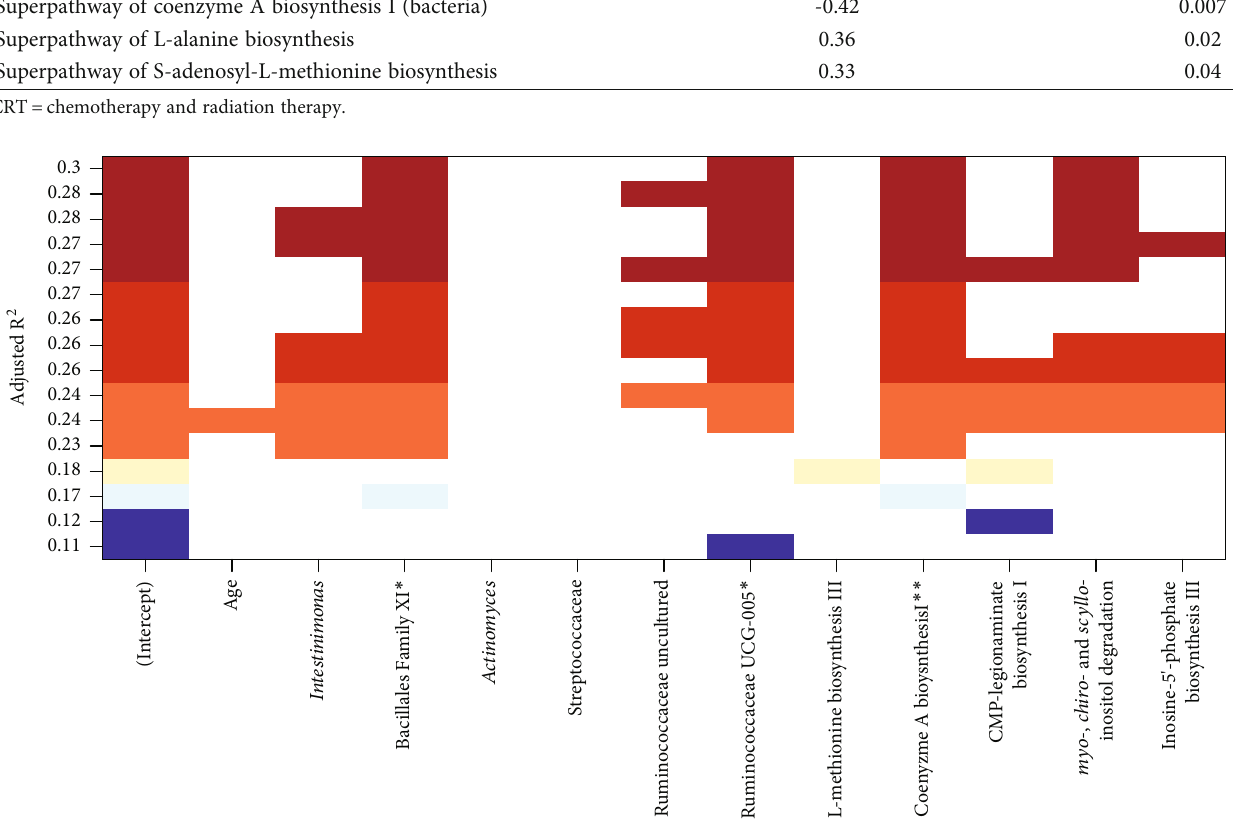
Figure 1: All subset regression results showing, for each subset size, the two subsets of predictor variables yielding the highest adjusted R 2 for predicting depressive symptom scores. ∗ indicates predictors (coe ffi cients) signi fi cantly correlated with depression scores, based on permutation test p values in the fi nal multiple regression